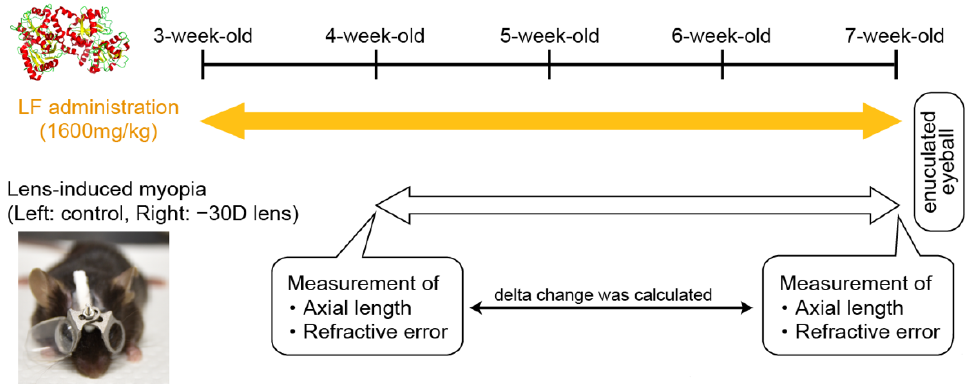
Figure 1. Procedure for oral lactoferrin (LF) administration and minus-lens-induced myopia.